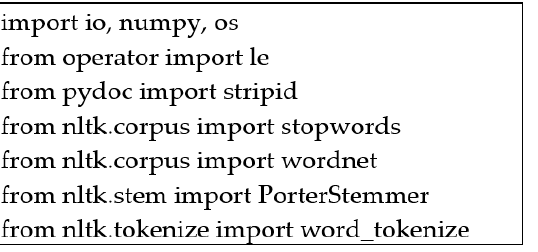
Figure 2. The external libraries that have been used in implementation.